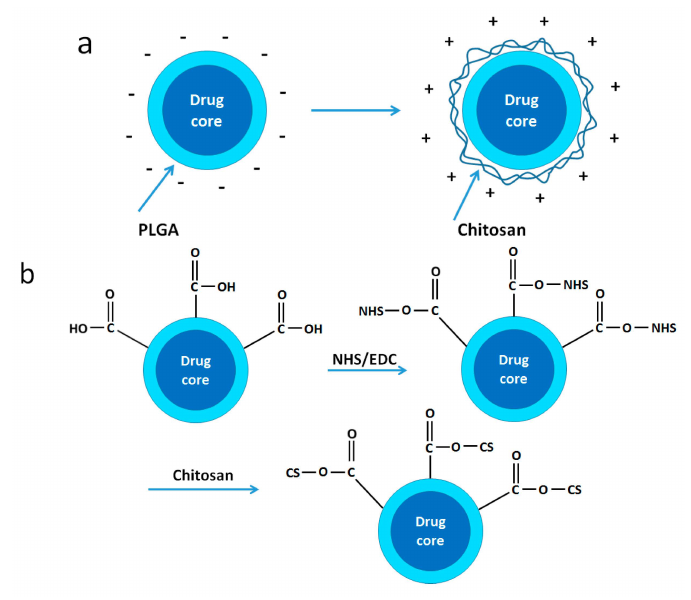
Figure 9. Schematic maps of chitosan modified poly(lactide-co-glycolide) nanoparticles (PLGA NPs) by ( a ) physical adsorption method and ( b ) chemical binding method. Reproduced with permission of [45]. Copyright Springer, 2016.